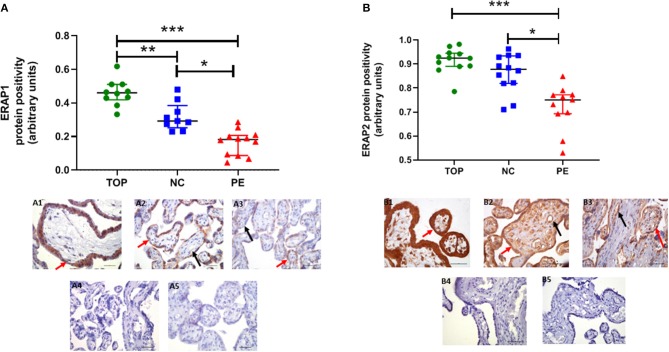
Protein expression assessed by immunohistochemistry. (A) Endoplasmic reticulum aminopeptidase (ERAP)1, (B) ERAP2 in placentae from first trimester (TOP; n = 12), term normotensive controls (NC; n = 12), and women with pre-eclampsia (PE; n = 12). Data are presented as median [interquartile range (IQR)]; *P < 0.05; **P < 0.01; ***P < 0.0001. Photomicrographs show typical examples of immunostaining in (A1) TOP, (A2) NC, (A3) PE, (A4) IgG negative control, (A5) negative control—no primary antibody. Positive protein expression appears brown and is localized mainly to the syncytiotrophoblast (red arrows) but is also evident around the fetal vessels (black arrows); scale bar = 100 μm; magnification ×400.